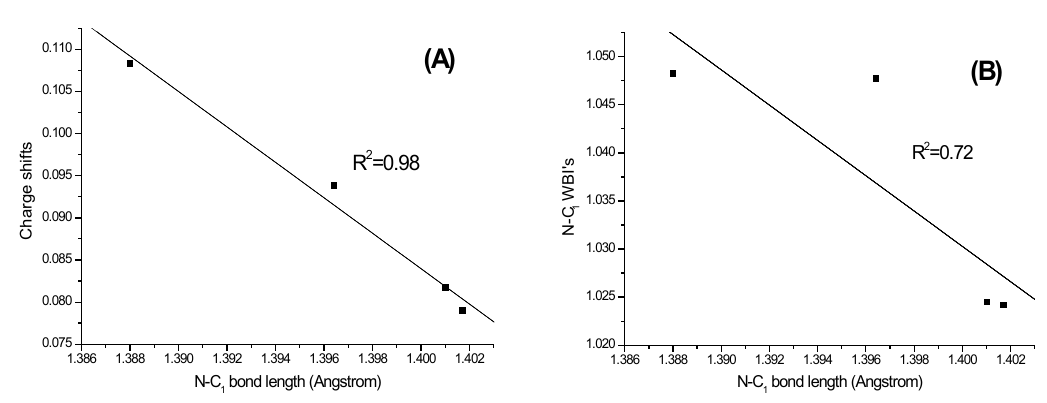
Figure 4. Various correlations among the N-C